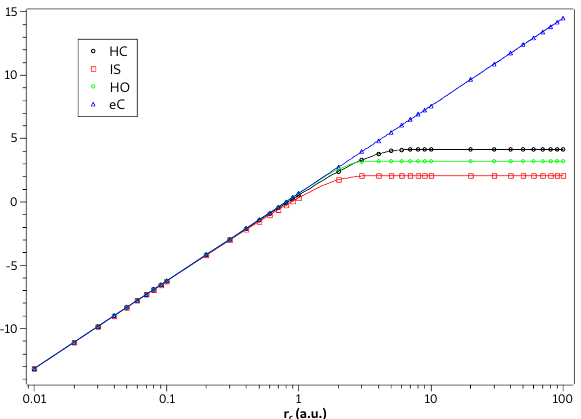
Figure 7. Values of S r in ground state as a function of r c on logarithmic scale for the hydrogen confined (HC), ion-sphere (IS), confined harmonic oscillator (HO), and particle confined